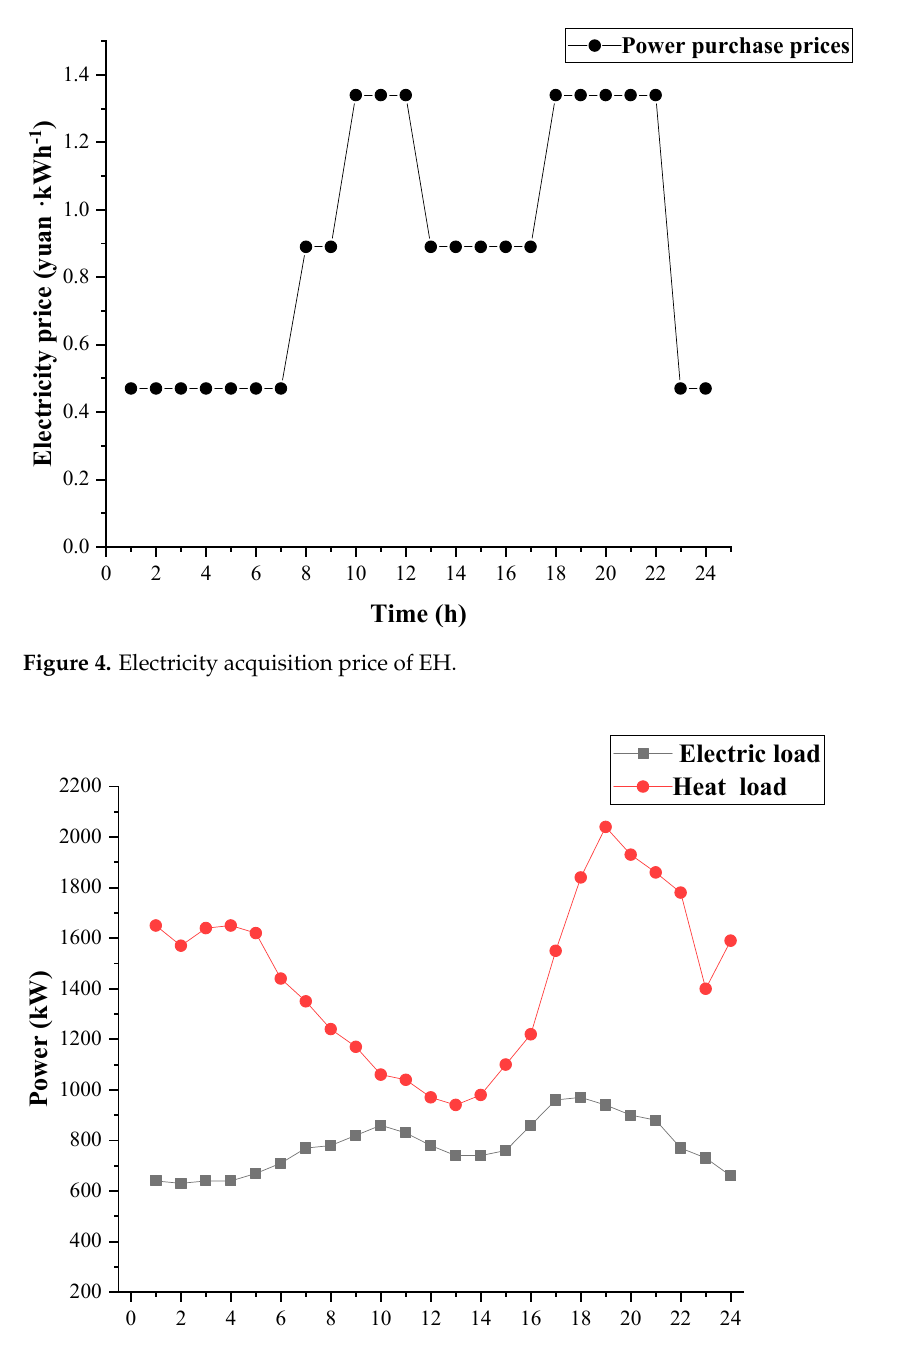
Table 3. Price elasticity of EFL-TSL demands.